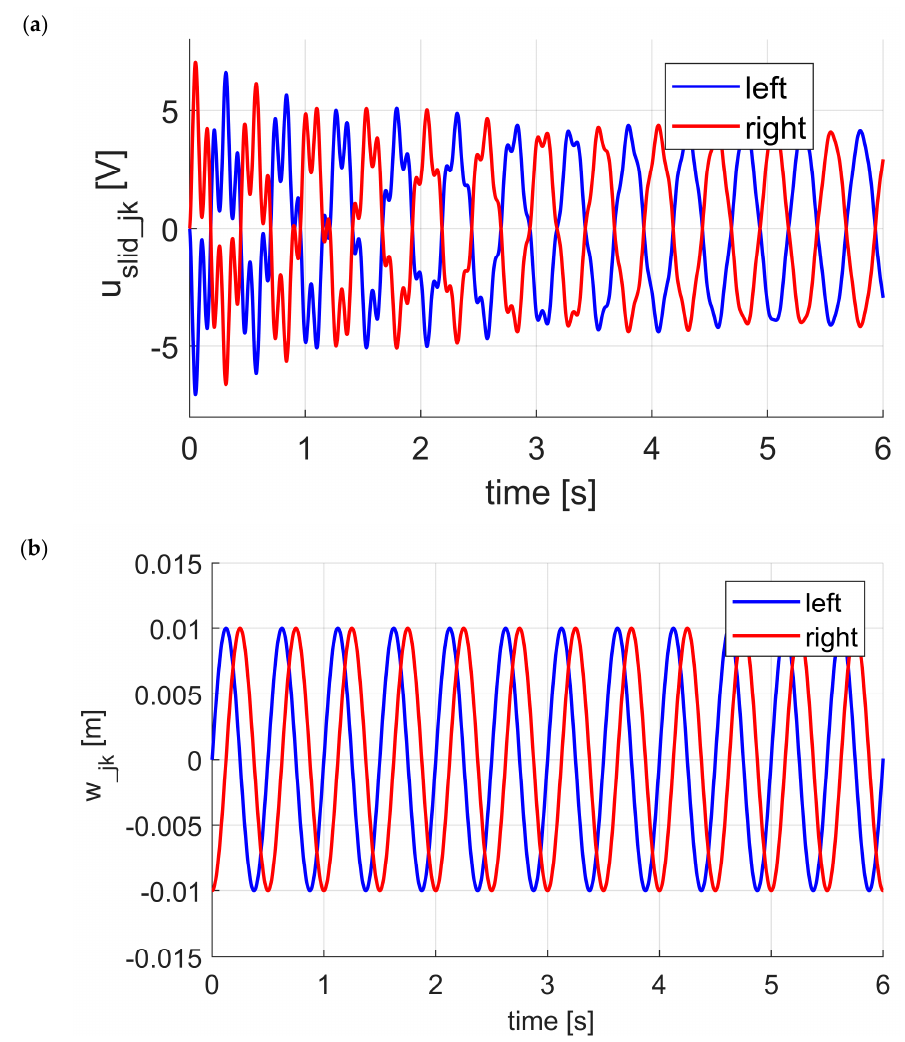
Figure 6. Time courses of the signals generated by the SMC for the left and right strut ( a ) and simulated road disturbances ( b ) for (cid:1827) (cid:3050)_(cid:3037)(cid:3019) = (cid:1827) (cid:3050)_(cid:3037)(cid:3013) = 0.01 m,(cid:1858) (cid:3050)_(cid:3037)(cid:3019) = (cid:1858) (cid:3050)_(cid:3037)(cid:3013) = 2 Hz . road disturbances ( b ) for A